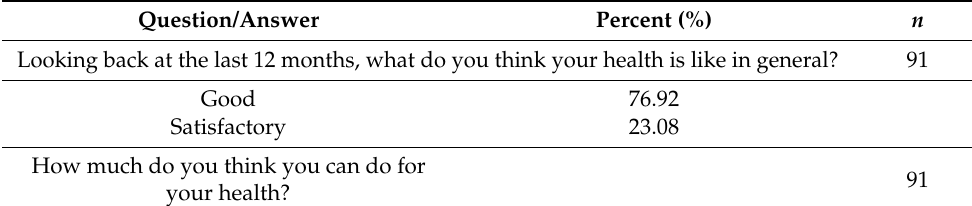
Table 9. The distribution of participants by percentage among specific answer categories of simple- and multiple-choice questions in postIQ ( n =